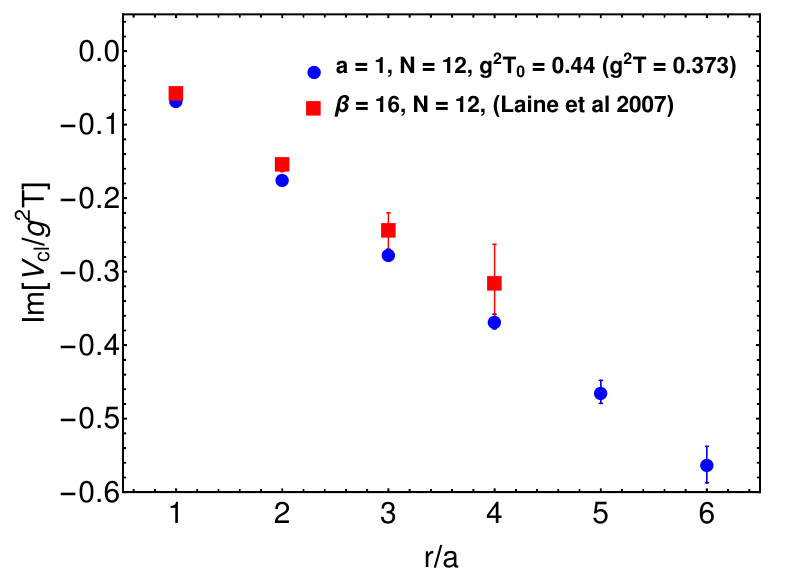
Figure 6 . Im[ V cl ( r )] /g 2 T as a function of r/a for β = 16 . The blue filled disks are the results obtain herein averaged over 28 configurations. The red filled squares are the results reported by Laine et al. in ref.